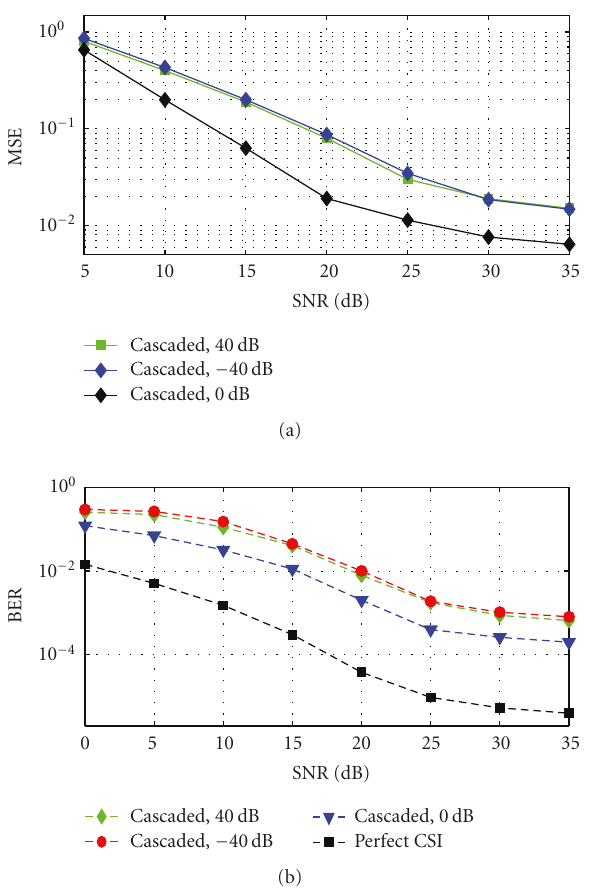
Figure 3: Performance of the cascaded channel estimation approach. (a) Change in the MSE by SNR, (b) BER versus SNR.